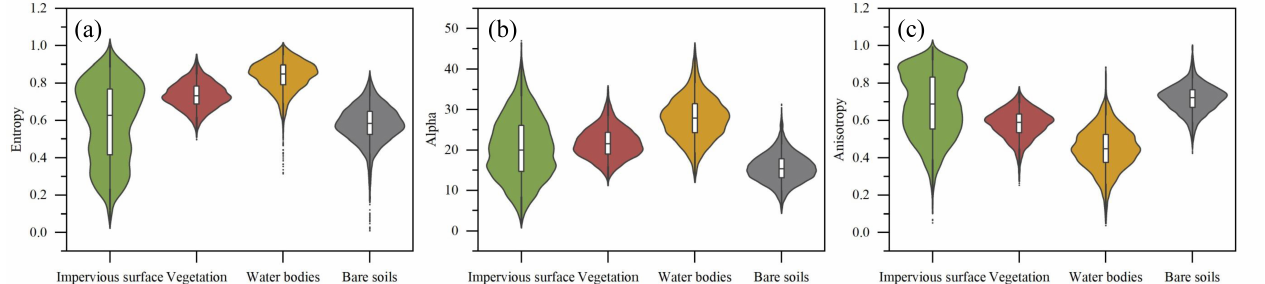
Figure 8. Differences in polarization features between impervious surfaces and other ground objects. ( a – c ) Differences between impervious surfaces and other ground objects based on H, Alpha, and